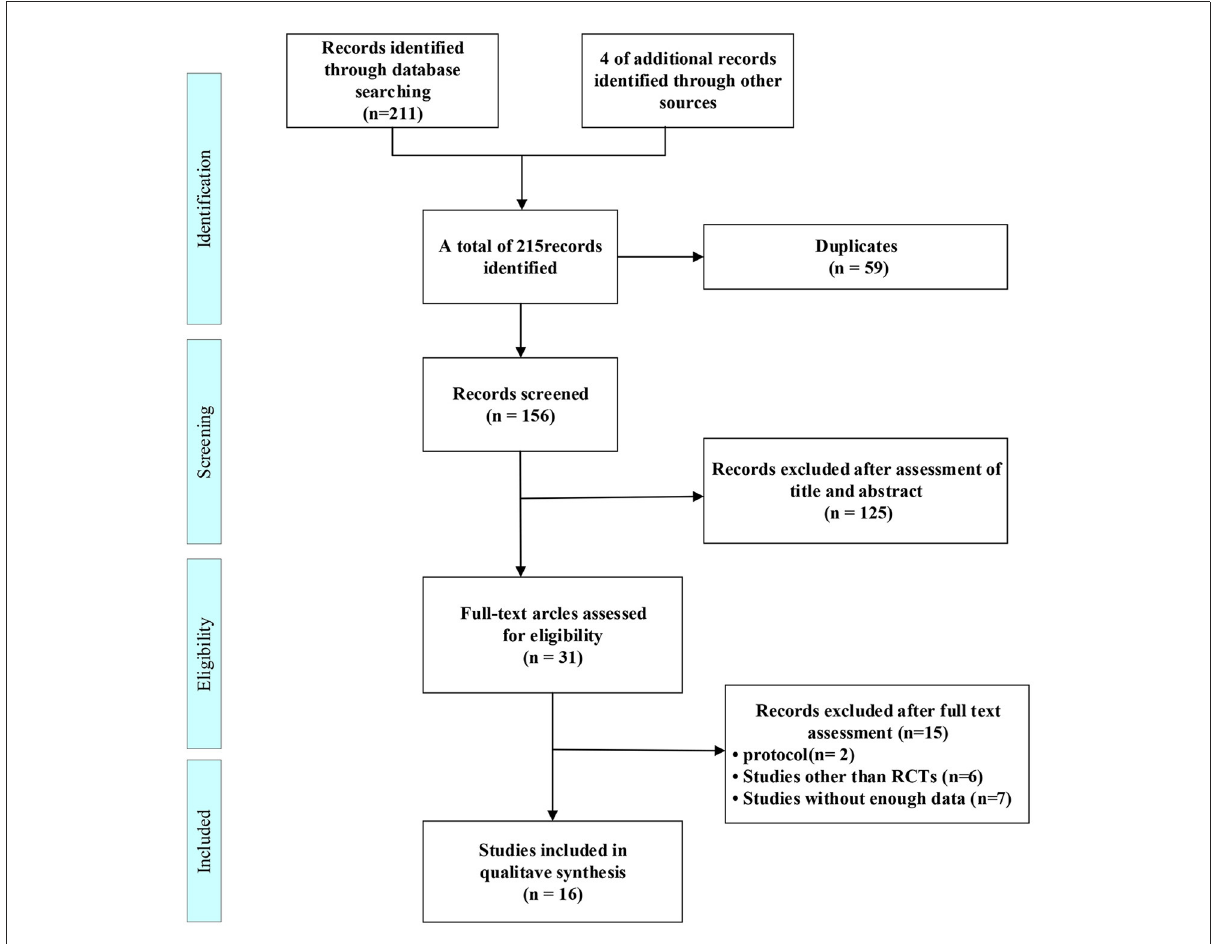
FIGURE1 The flowchart of the study selection process.